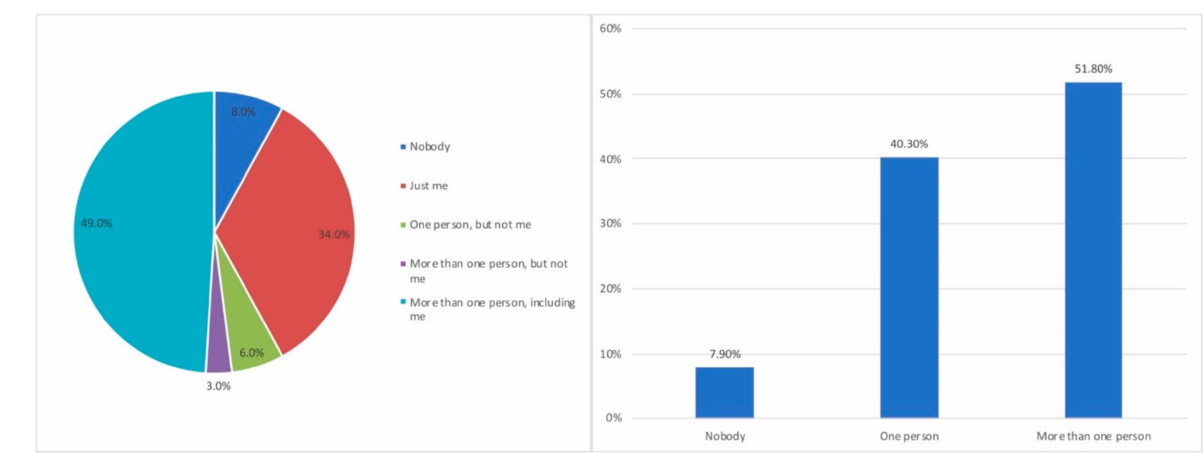
Figure 2. Distribution of people teleworking/tele-studying in homes, as requested in the questionnaire ( left ) and grouped by number of people ( right ).